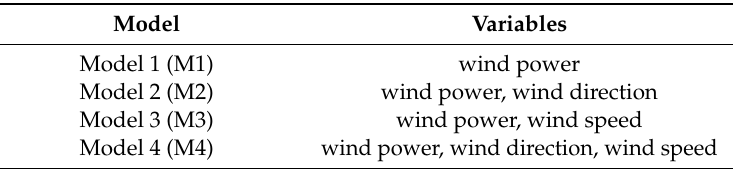
Table 3. Multivariate